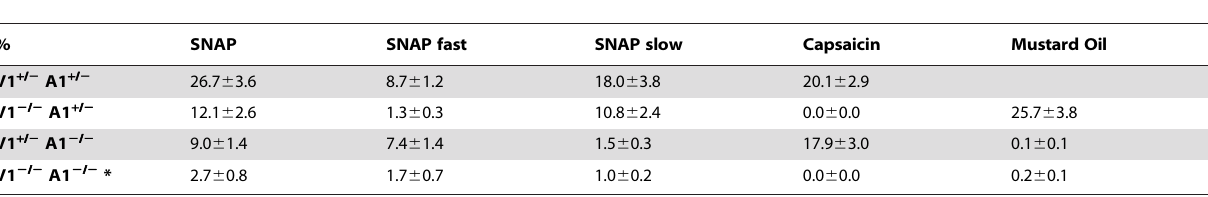
Table 2. PKA and PLC pathways sensitize TRPA1 to NO